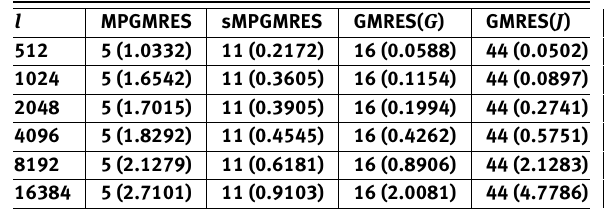
Table 5. The number of iterations and computing time in seconds (in brackets) for Example 4.2, when G and J are used as